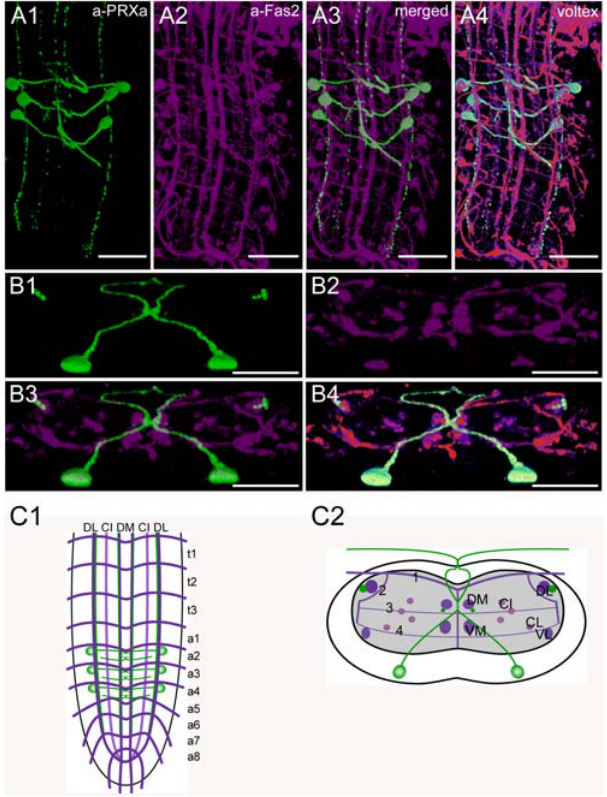
Figure 3. Morphology of CAPA- and HUGIN neurons. Mapping of PRXa-IR neurons in whole-mount preparations of the thoracic and abdominal neuromeres of L3 larva in the Fas2 landmark system. A) Dorsal view. B) Transversal view at the height of neuromere a3. C) Idealized dorsal scheme. D) Idealized transverse scheme. Scale bars: 50 m m in A ), 25 m m in B ). Immunostaining is shown in green, Fas2 in magenta.